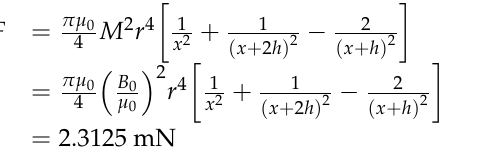
Figure 4. Diagram and dimensions of millirobot pedestal in millimeters.